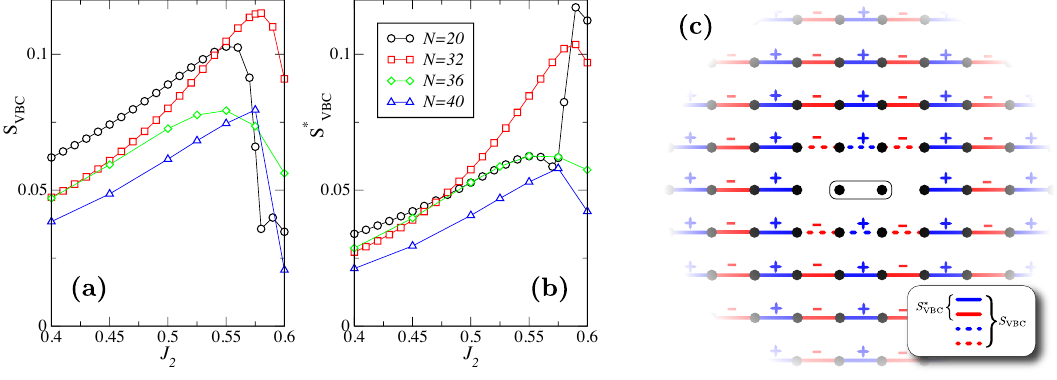
(cid:112) ×(cid:112) N N